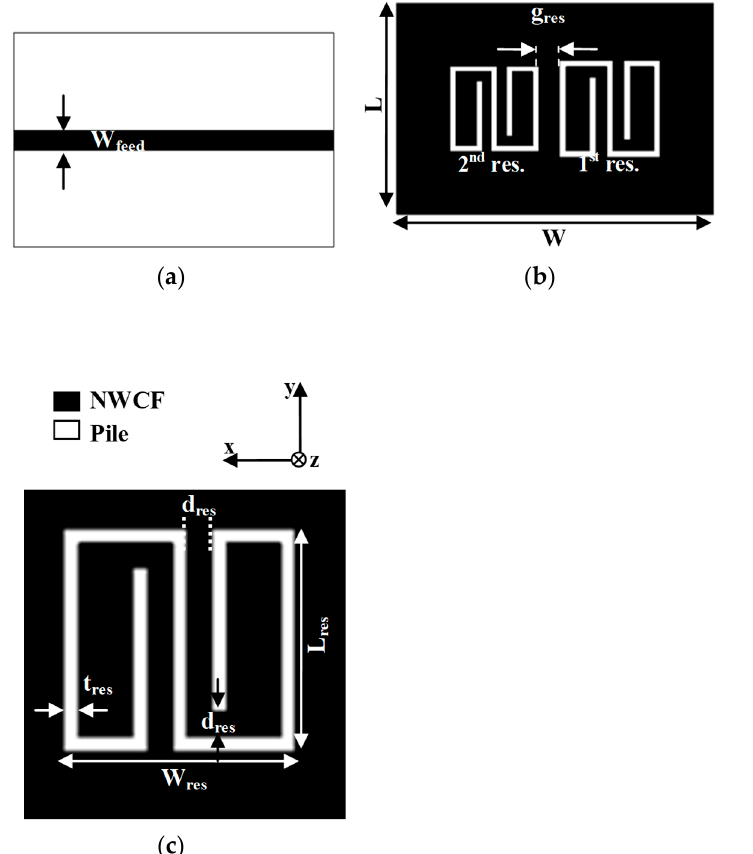
Figure 2. Geometry of the proposed multi-stopband structure: ( a ) front view of a 2-bit multi-stopband structure; ( b ) back view of a 2-bit multi-stopband structure; ( c ) geometry of the single resonator.